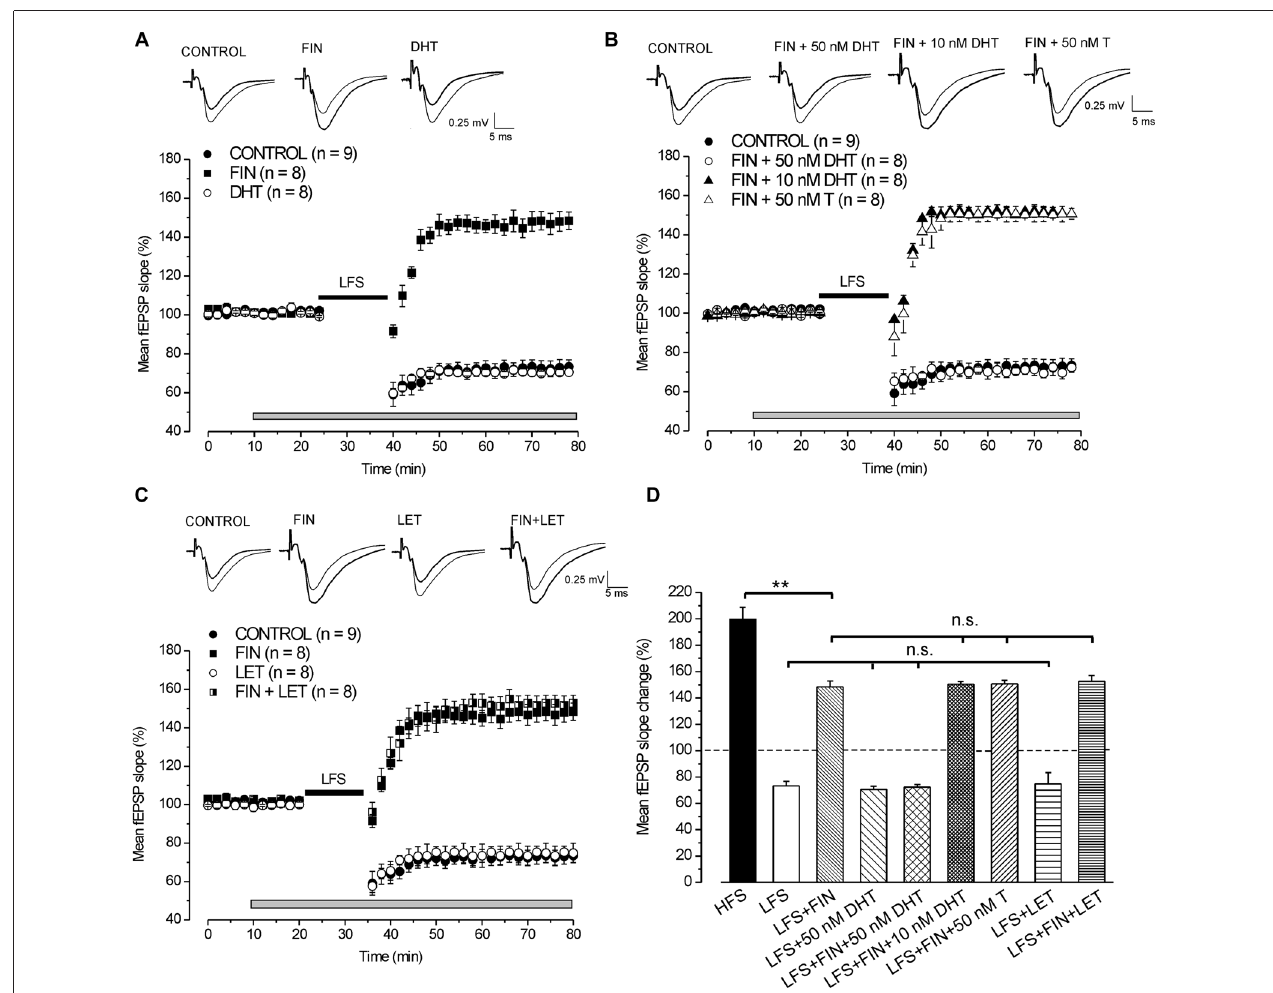
FIGURE 1 | Induction of long-term depression (LTD) by low frequency stimulation (LFS) depends on the synthesis of DHT. (A,C) Effects of LFS in the presence of different drugs. On the top of panels (A–C) averaged traces ( n = 20) of fEPSPs recorded before (thin traces) and 40 min after LFS (thick traces) in different experimental conditions. Graphs in this and following figures report mean ± SEM ( n = number of slices) of the fEPSP slope evaluated within 2-min interval and expressed as a percentage of the baseline. The gray bars show the drug infusion time and the black bars the LFS delivering time. (A) Effect of LFS in control condition (filled circles), under finasteride (FIN, filled squares) and 50 nM DHT (open circles). (B) Effect of LFS in control condition (filled circles), under FIN + 50 nM DHT (open circles), FIN + 10 nM DHT (filled triangles) and FIN + 50 nM T (open triangles). (C) Effect of LFS in control condition (filled circles), under FIN (filled squares), letrozole (LET, open circles) and FIN + LET (half-filled squares). (D) Comparison of the fEPSP changes induced by high frequency stimulation (HFS) in control condition and by LFS under different drugs as shown in (A–C) . In this and following bar charts data represent mean ± SEM of the fEPSP slope (% of the baseline). Comparisons among long-term potentiation (LTP) (one-way analysis of variance (ANOVA), F 8,72 = 54.2, p < 0.0001; Tukey’s post hoc test, ∗∗ p < 0.001; n.s. = no significant) and LTD (one-way ANOVA, F 3,29 = 0.2, p = 0.85). Note that without synthesis of DHT, LFS is able to induce a partial LTP that is not dependent on the E2